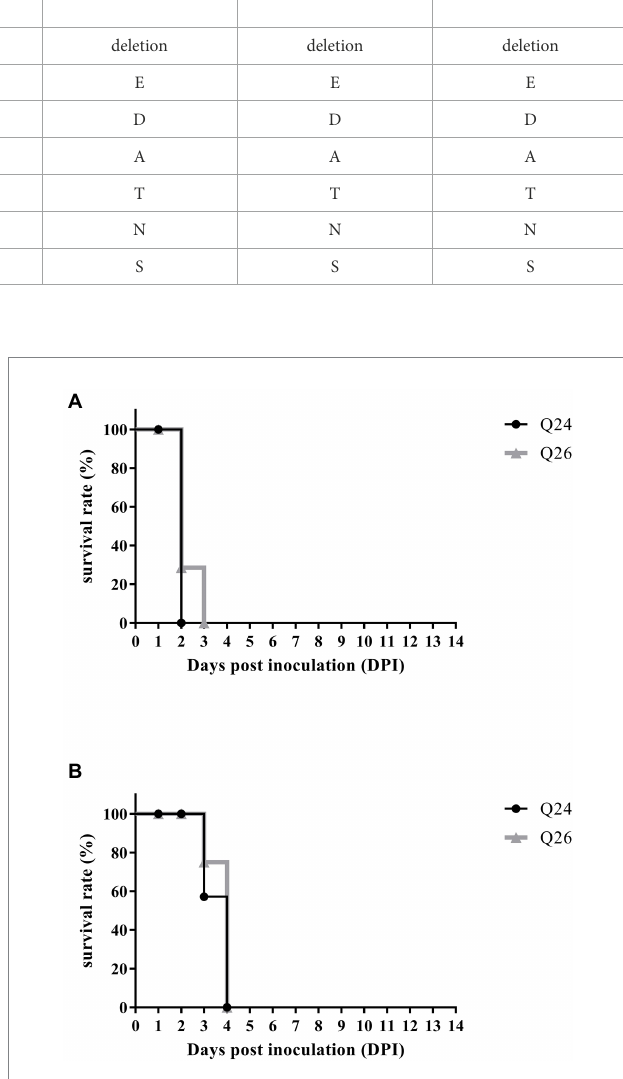
FIGURE 9 The percent survival of the inoculated and contact chickens. Six inoculated chickens in the Q24 or Q26 group were observed daily for clinical symptoms and mortality, respectively. Five contact chickens were housed with the inoculated chickens in each group, respectively, to measure viral transmission in chickens (direct contact transmission). The survival curves of (A) inoculated and (B) contact chickens were drawn basing on GraphPad Prism 7.0